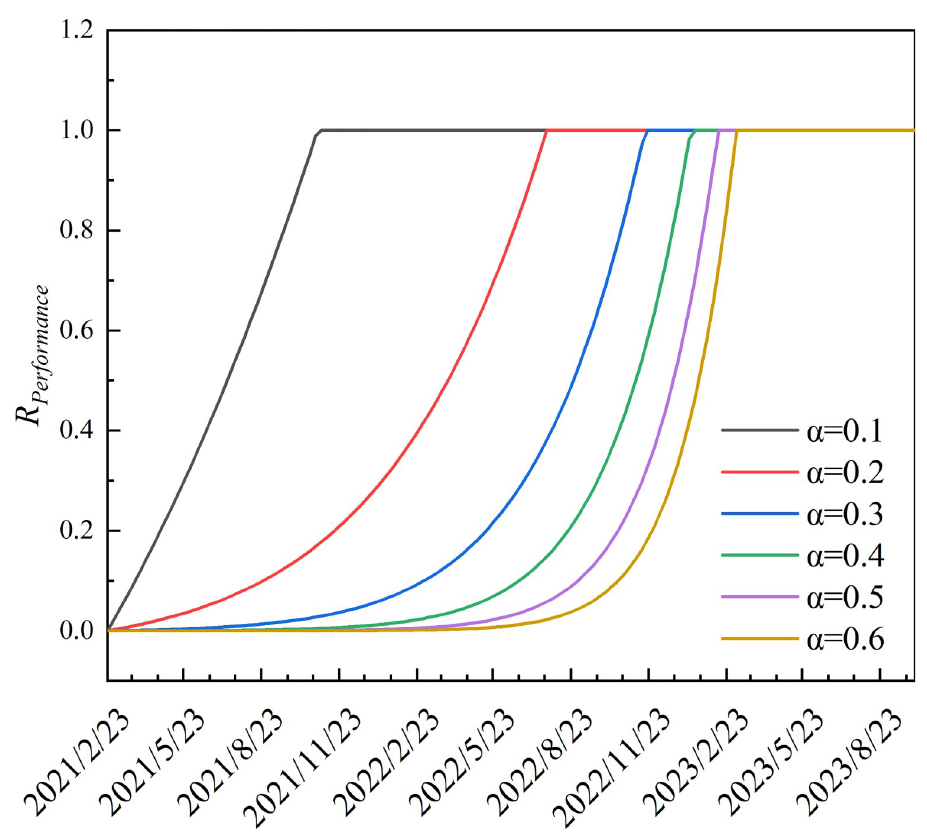
Fig 2. CRA function of airport network recovery